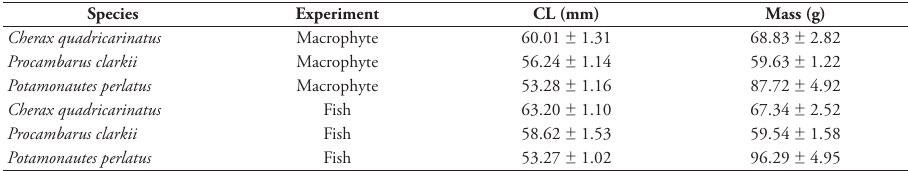
Table 1. Morphometric averages (mean ± SE) of Cherax quadricarinatus , Procambarus clarkii and Pota- monautes perlatus used in the macrophyte consumption and fish scavenging